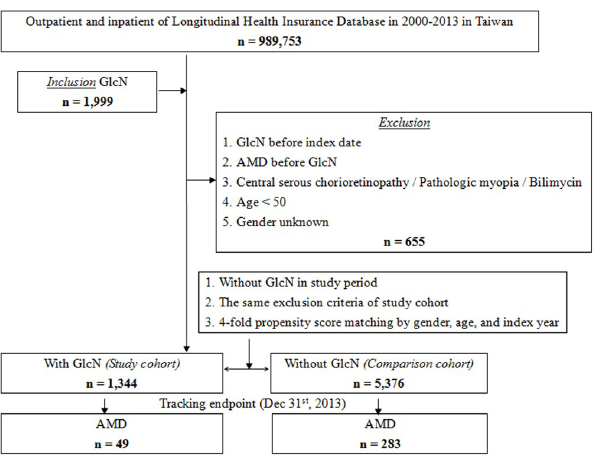
Fig 1. Flowchart of patient selection from the National Health Insurance Research Database in